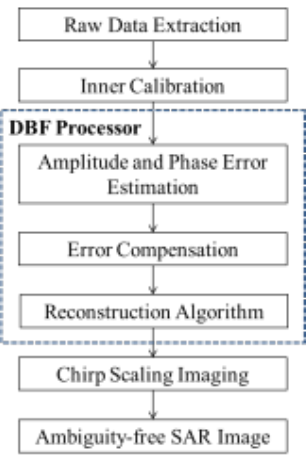
Figure 3. The processor of Gaofen-3 ultra-fine stripmap